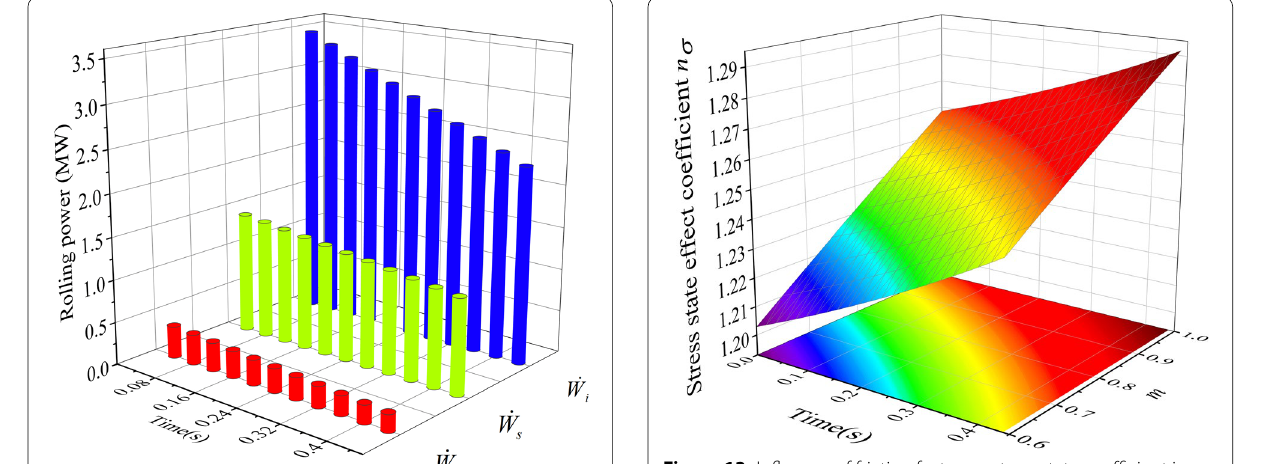
Figure 13 Influence of friction factor on stress state coefficient in upward rolling